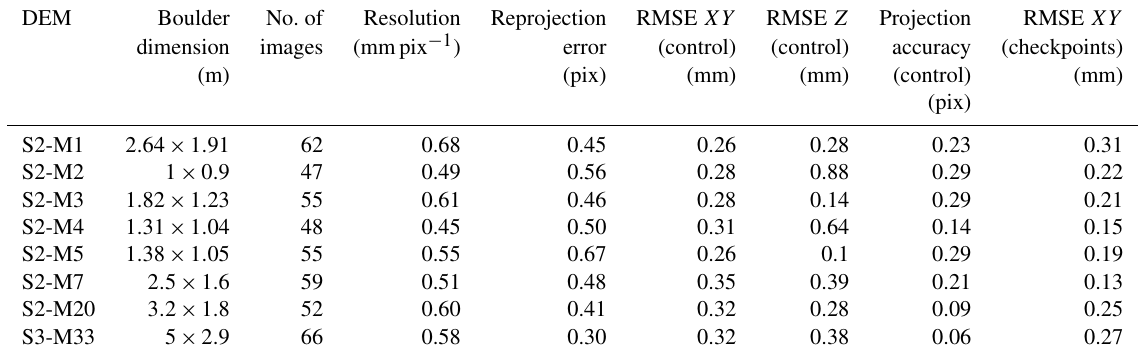
Table 5. Field DEM data summary. DEM Boulder No. of Resolution Reprojection RMSE XY RMSE Z Projection RMSE XY dimension images (mmpix − 1 ) error (control) (control) accuracy (checkpoints) (m) (pix) (mm)